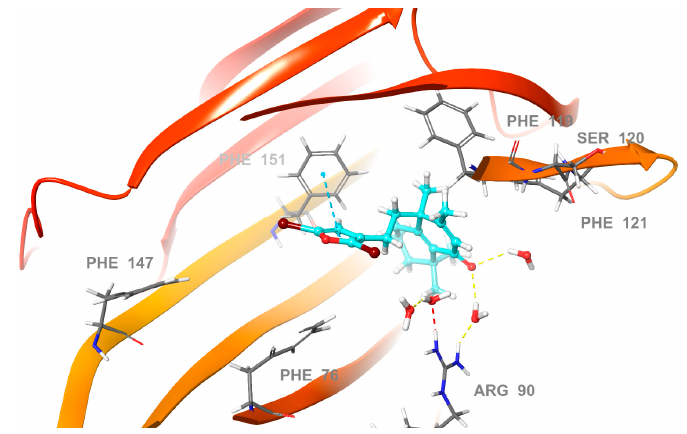
Figure 9. Docking model and key interactions of compound 5 into the TLR4 active site (PDB 4G8A).